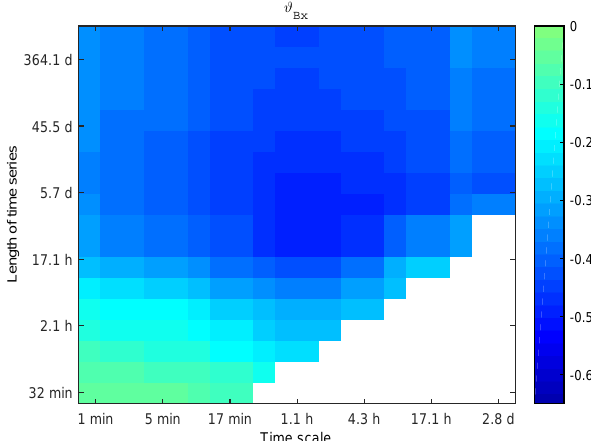
Figure 7. Correlation between Pc3 ind and ϑ B at different x different timescales (horizontal axis) and data set lengths (vertical axis). and THY x